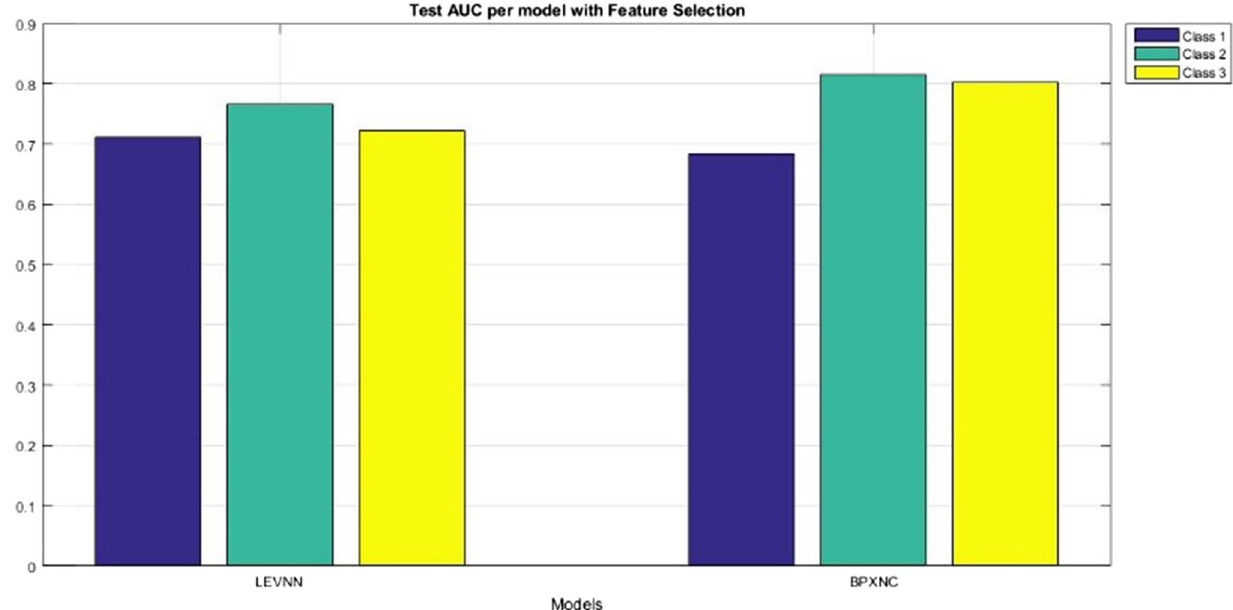
Fig. 13 AUC plot for ANN